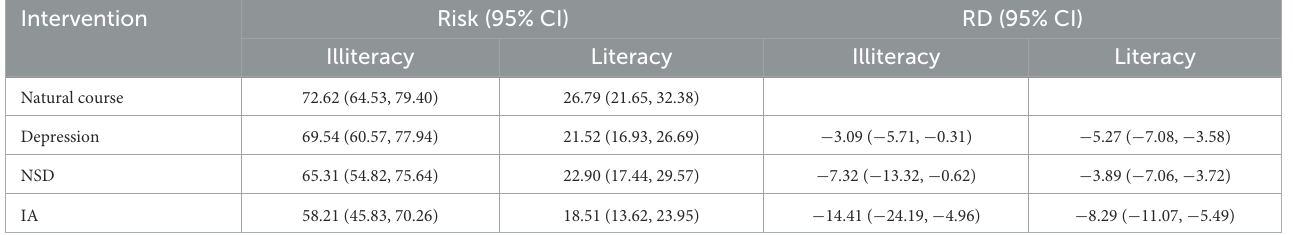
TABLE 5 Cognitive impairment risks at 7-year follow-up under natural course and single hypothetical interventions in subgroups stratified by education. Intervention